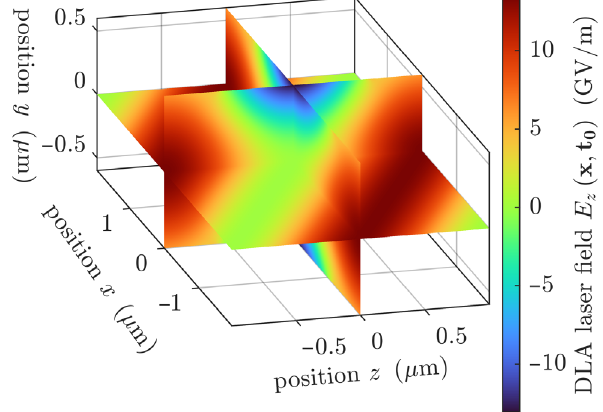
17. 3D field map of the laser distribution in the beam channel of a tilted silica DLA grating unit cell. The simulations conducted with the particle tracking code ASTRA [43] use a periodic extension in order to model the field distribution of the full DLA